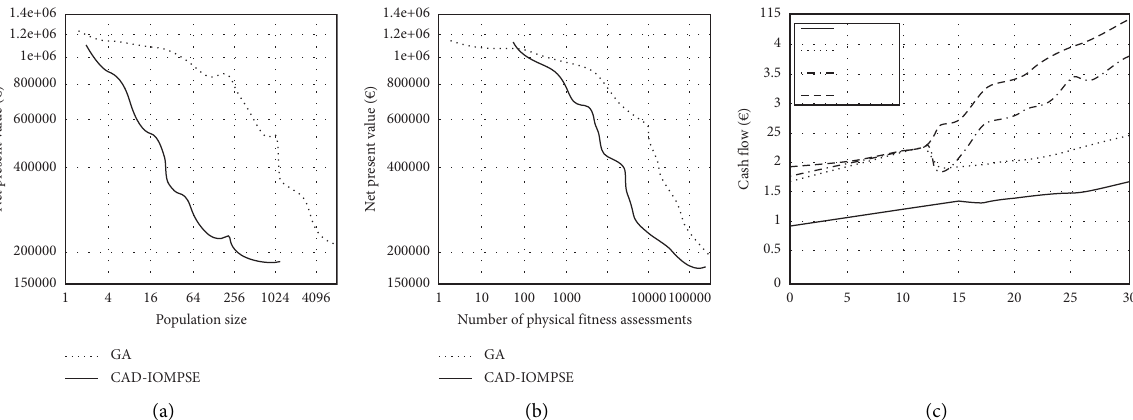
Figure 6: Classic scenario with electronic rule variant A: the performance of the algorithm (a and b) and cash flow over time